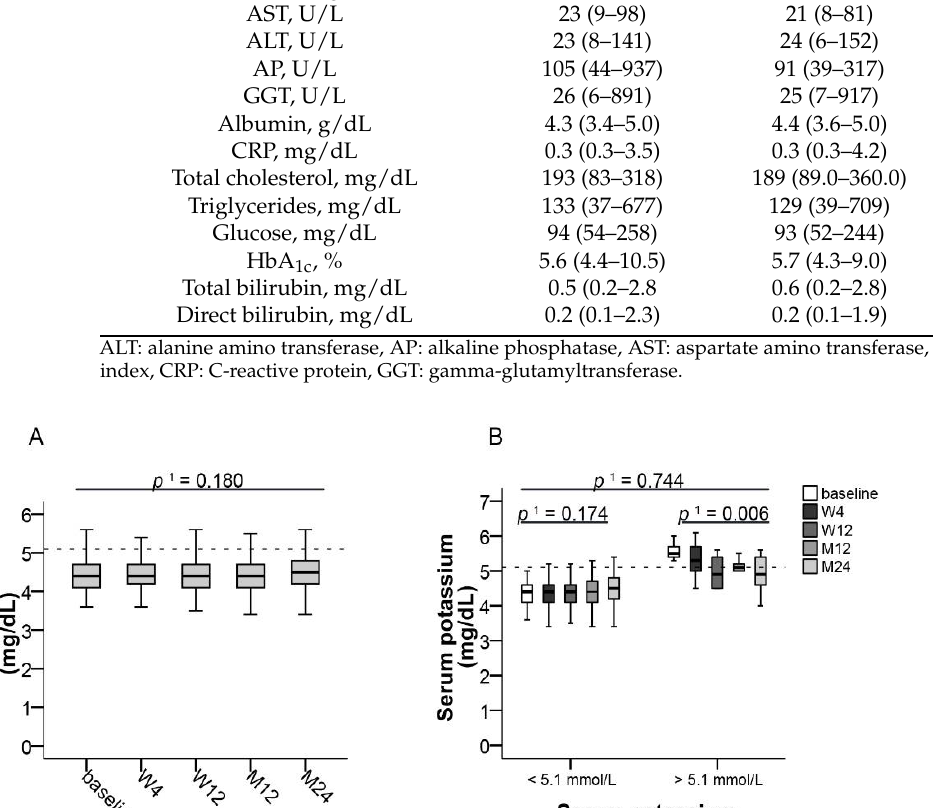
Table 2. Laboratory parameters at baseline and at 24 months after switching to LCPT.